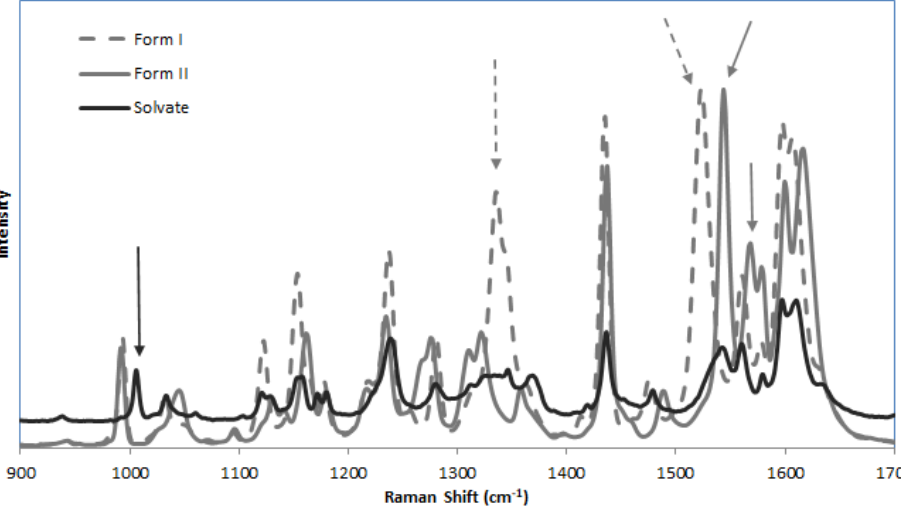
Figure 4. (1-column fitting) Raman spectra of piroxicam form I, form II and the solvate of acetic acid. Arrows are inserted to show characteristic